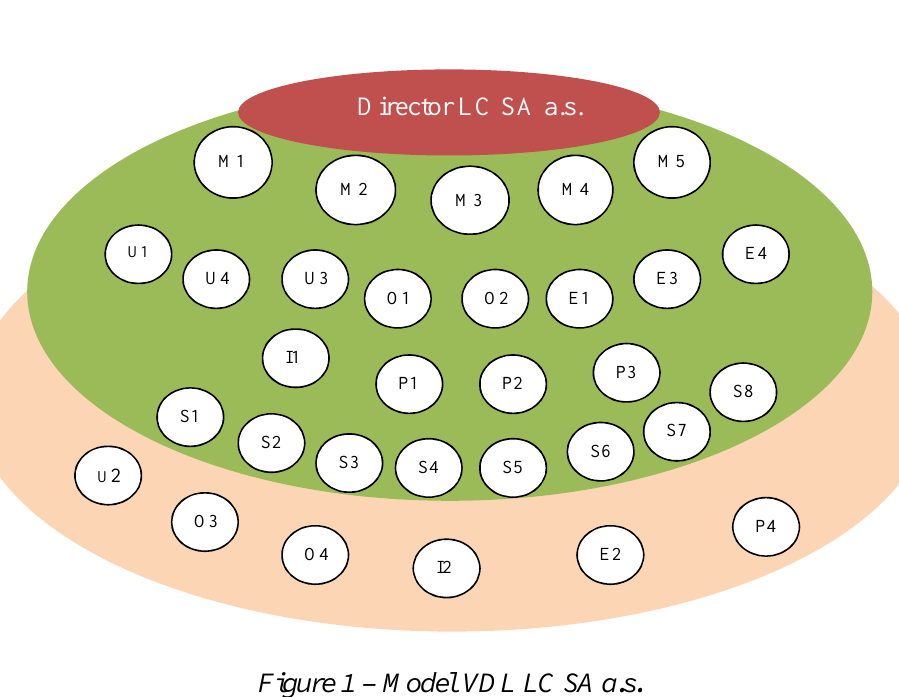
Figure 1 – Model VDL LC SA